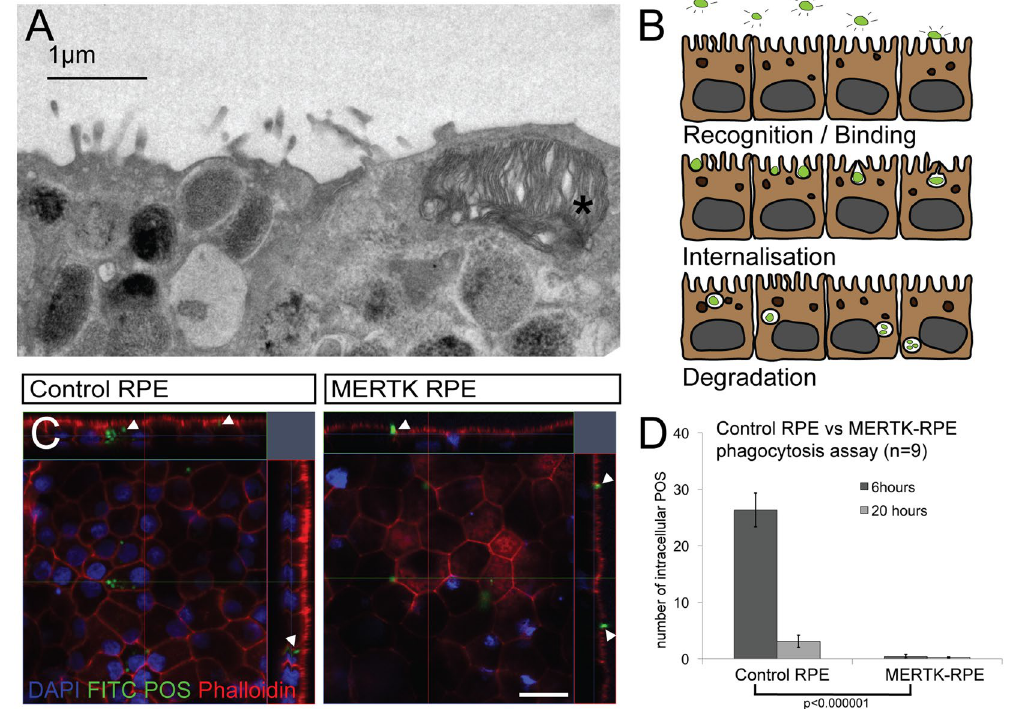
Figure 3. MERTK-RPE are unable to phagocytose. ( A ) Electron micrograph of the apical surface of the control RPE 4 hours following the addition of isolated photoreceptor outersegments (POS) * . ( B) Schematic of the process of POS phagocytosis by RPE using FITC labeled POS. ( C ) Orthogonal representations of confocal Z stacks of the control RPE and MERTK-RPE 6 hours following the addition of FITC labeled POS (scale bar = 20 μ m), arrows highlight POS. ( D ) Graphical representation of phagocytosis between control RPE and MERTK-RPE at 6 and 20 hours (error bars represent the mean ± 1SEM and p value derived from students